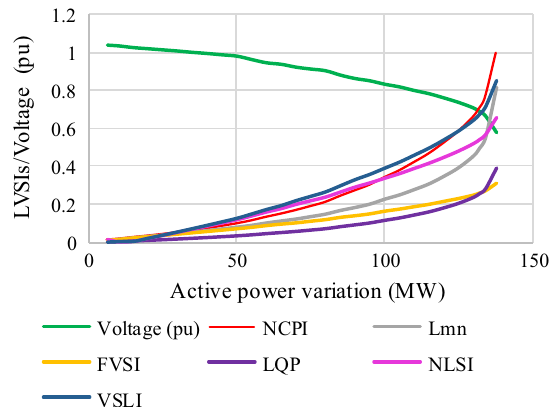
Fig. 6 Variations of line voltage stability indices (LVSIs) for branch 14–15 during active power variations at bus 14